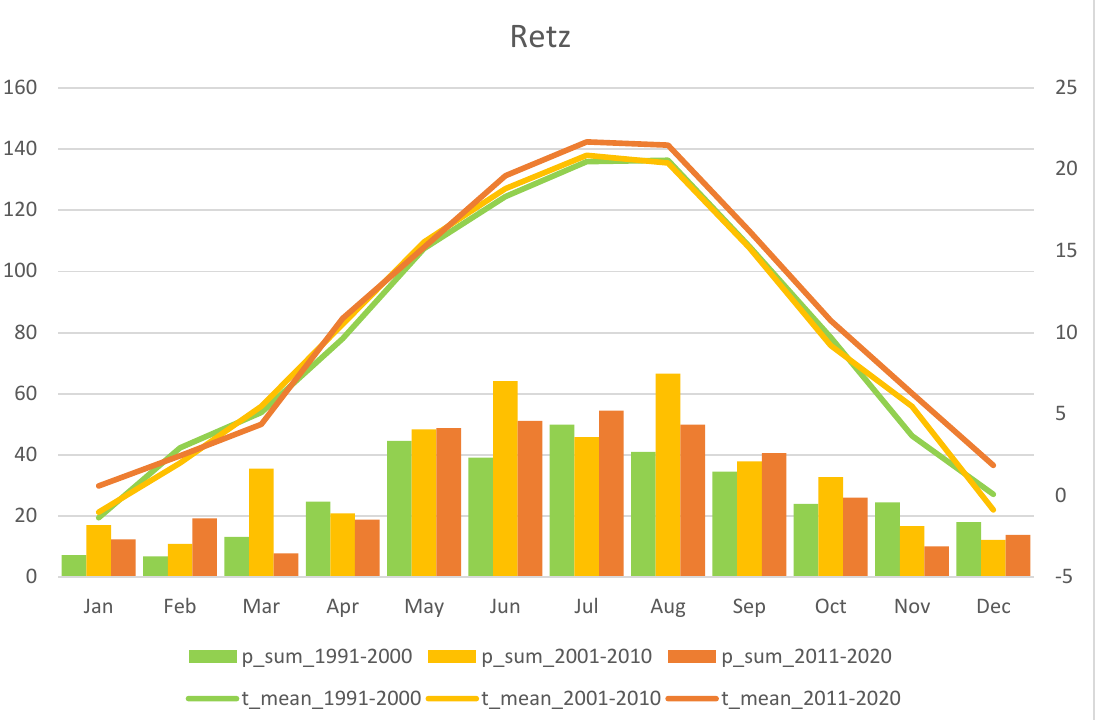
Figure A10. Mean monthly precipitation sum (p_sum; columns) and air temperature (t_mean; lines) for the last three recent decades, i.e. 1991 – 2000, 2001 – 2010, and 2011 – 2020. The Retz station is rep- resentative for the Weinviertel region (source: ZAMG - https://data.hub.zamg.ac.at).